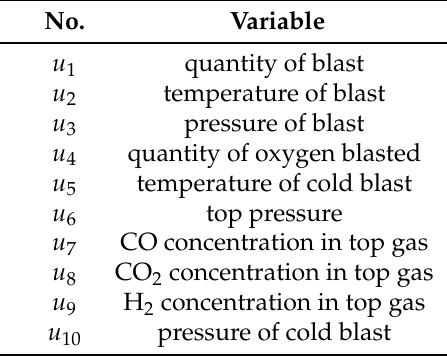
Table 3. The input variables for Case